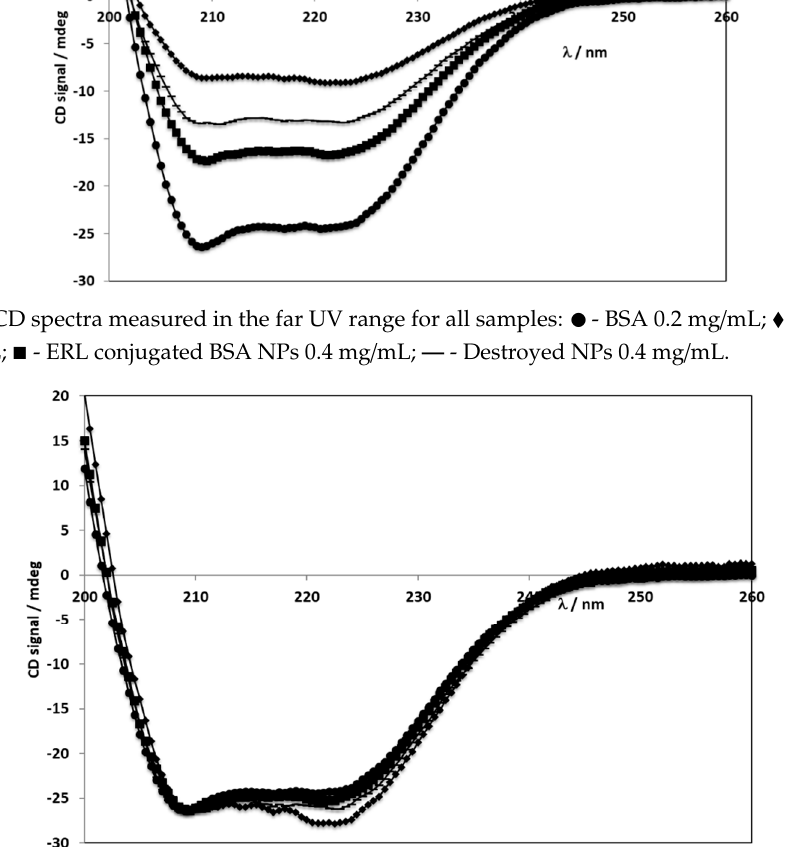
Figure 3. CD spectra measured in the far UV range after normalization – all spectra having the same intensity as BSA ( ● - BSA 0.2 mg/mL; ♦ - BSA NPs 0.4 mg/mL; ■ – ERL conjugated BSA NPs 0.4 mg/mL; ▬ - Destroyed NPs 0.4 mg/mL).